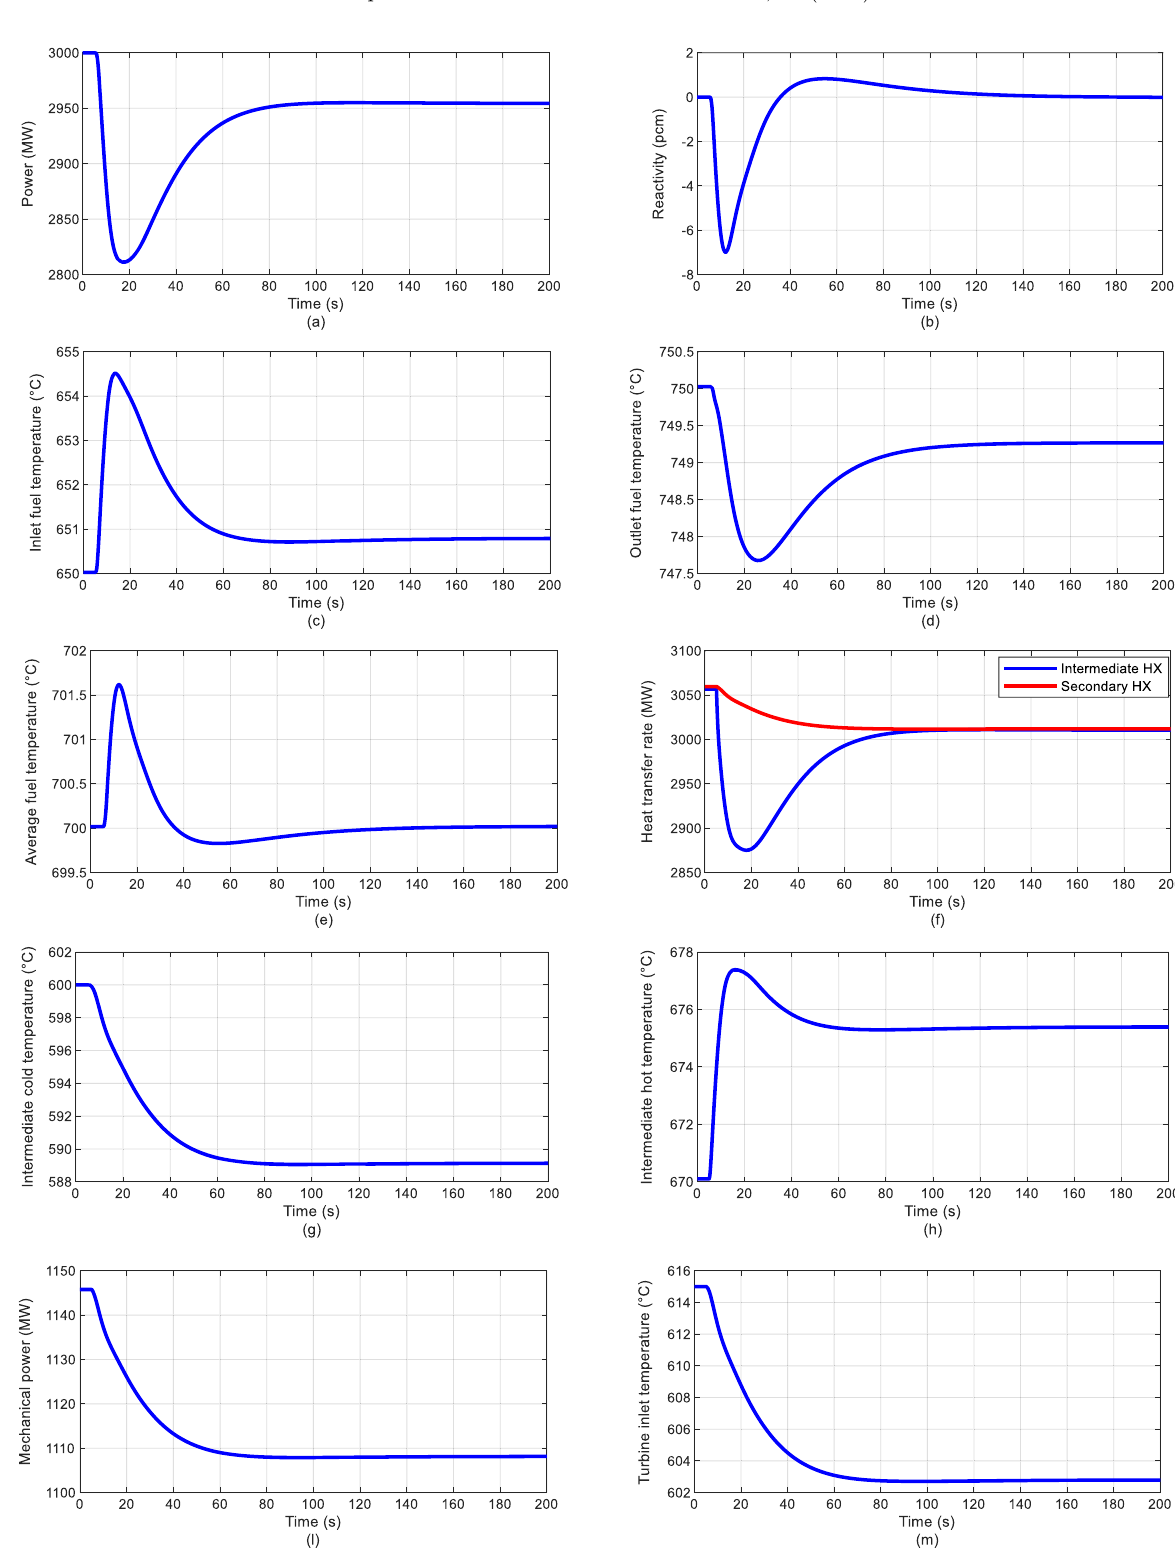
Fig. 14. Controlled variables evolution for 20% decrease of the intermediate salt mass fl ow rate: (a) reactor thermal power; (b) net reactivity variation; (c) fuel inlet temperature; (d) fuel outlet temperature; (e) fuel average temperature; (f) heat transfer rates in the heat exchangers; (g) intermediate salt minimum temperature; (h) intermediate salt maximum temperature; (i) turbine mechanical power; (m) helium turbine inlet